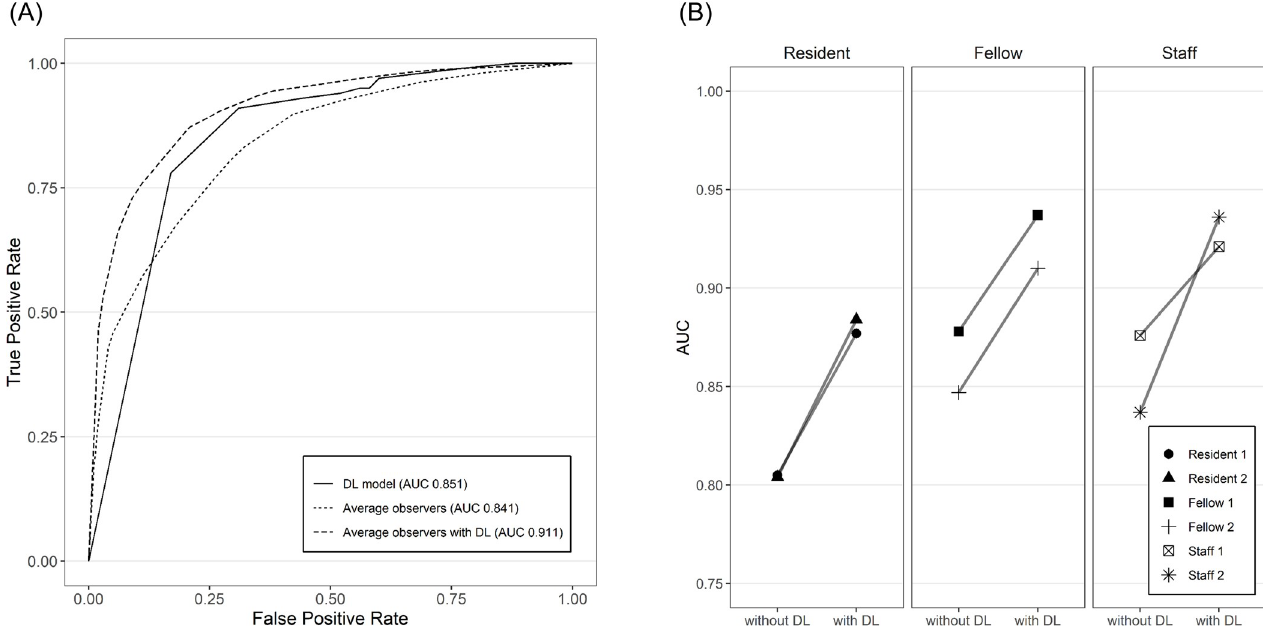
Fig 5. Comparison of observer performances with and without the DL model (a) ROC curve of the DL model and average observers in per-patient analysis. The AUC of the DL model alone was 0.851 (95% CI, 0.799–0.903), and that for average observers was 0.841 (95% CI, 0.781–0.901). The AUC of average observers improved to 0.911 (95% CI, 0.876–0.945) when referring to the results of the DL model. (b) Improved diagnostic performance of individual observers in per-patient analysis with the assistance of the DL model. ROC, receiver operating characteristics; DL, deep learning; AUC, area under the curve.